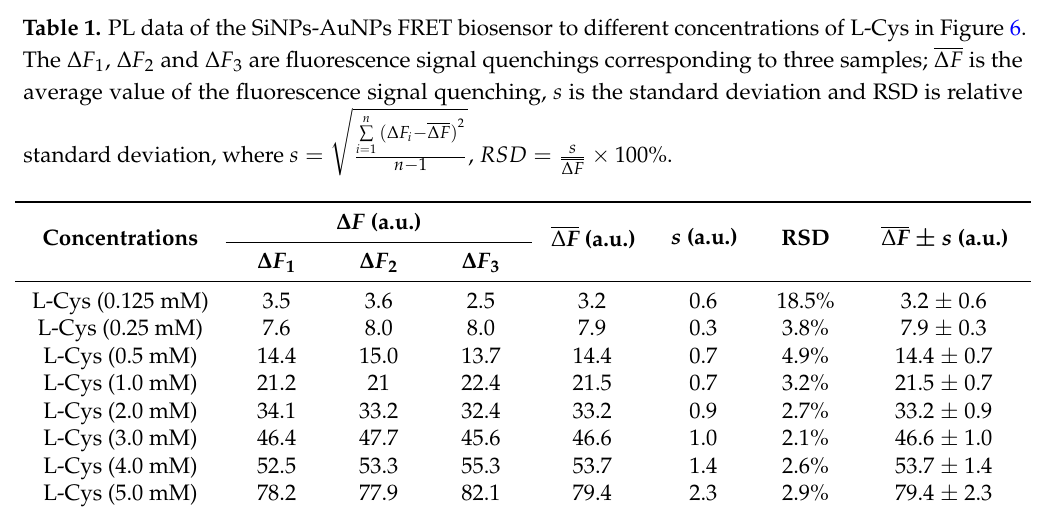
(cid:115) n ∑ ( ∆ F i − ∆ F ) 2 × 100%. i = 1 , RSD = s ∆ F n − 1 ∆ F (a.u.) ∆ F (a.u.) s (a.u.) RSD ∆ F ± s (a.u.) ∆ F ∆ F ∆ F 1 2 3